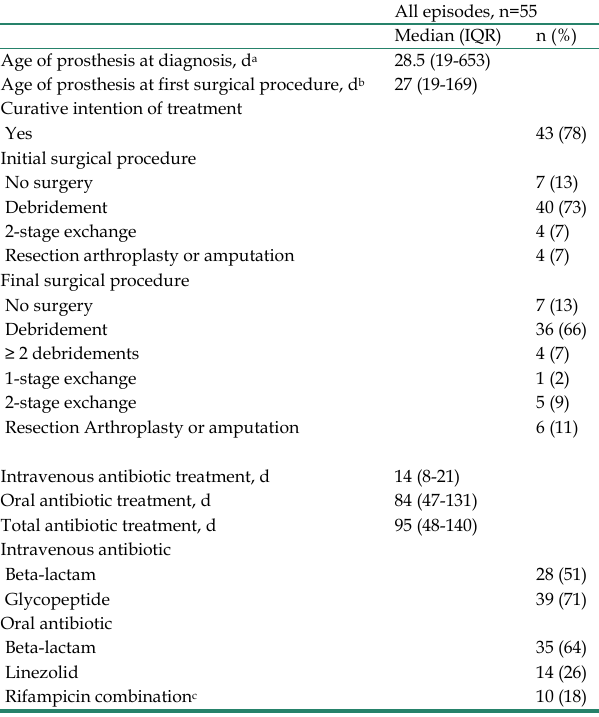
Table 2. Details of diagnosis and treatment of enterococcal